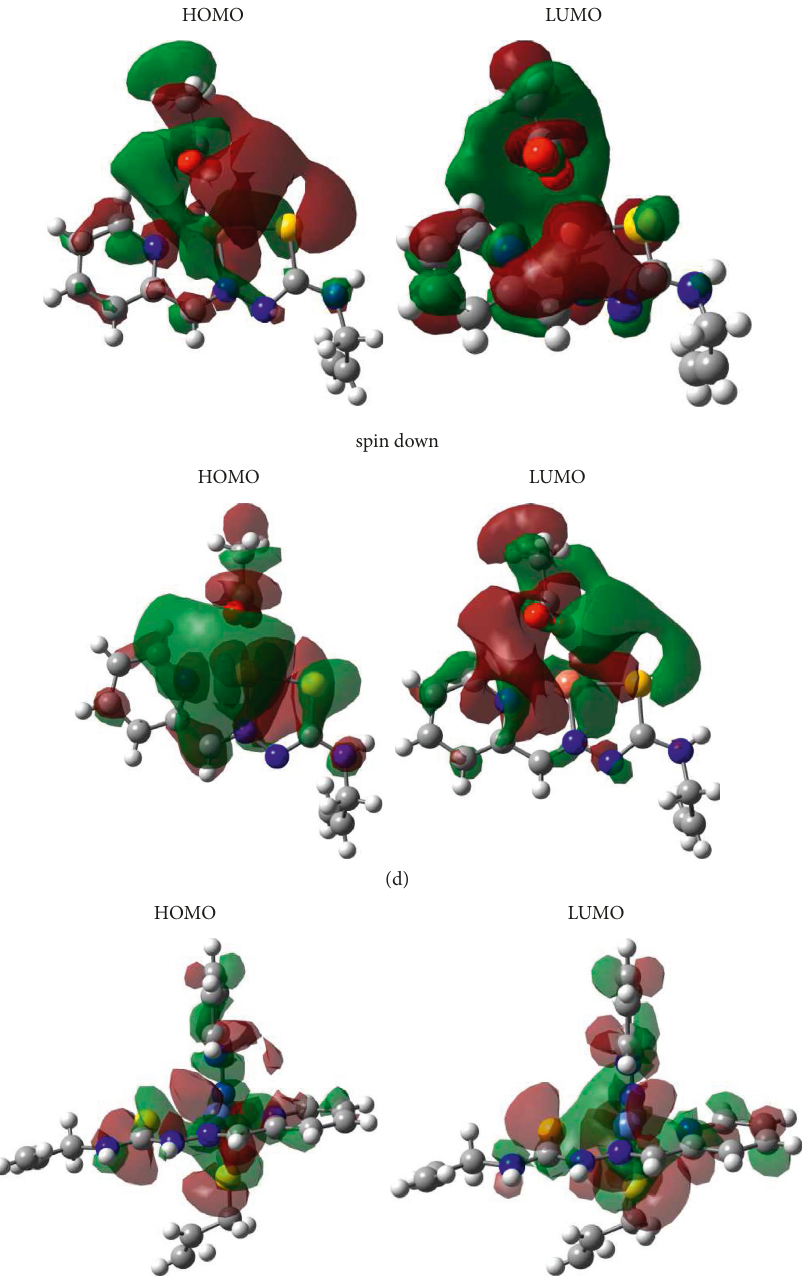
Figure 5: View of frontier molecular orbitals (HOMO and LUMO) for (a) HL , (b) HL a , (c) HL b , (d) 4 , and (e) 5